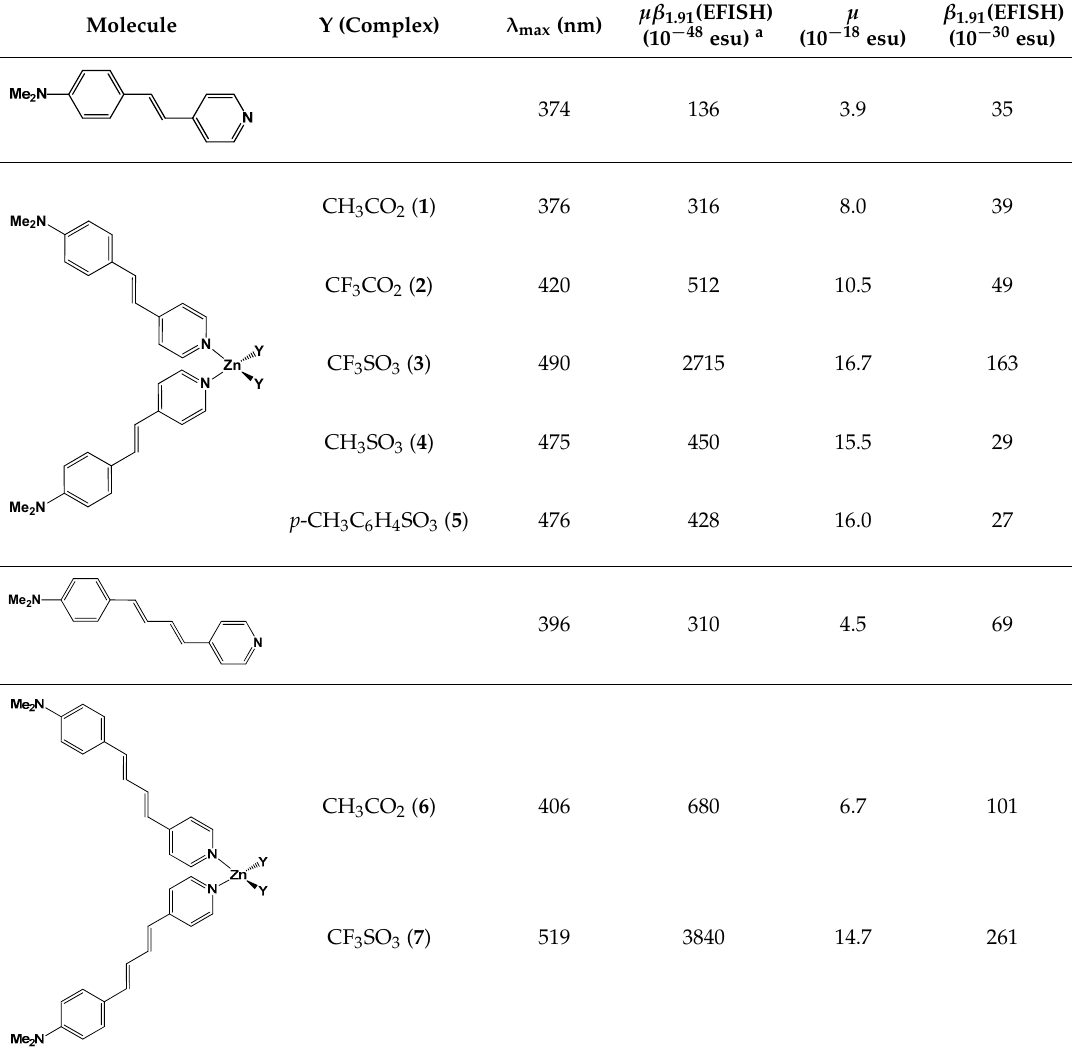
Table 1. Electronic spectra, dipole moments, and β 1.91 (EFISH) of Zn(II) stilbazole complexes in CHCl 3 solution [38–40]. EFISH: electric field-induced second harmonic generation.